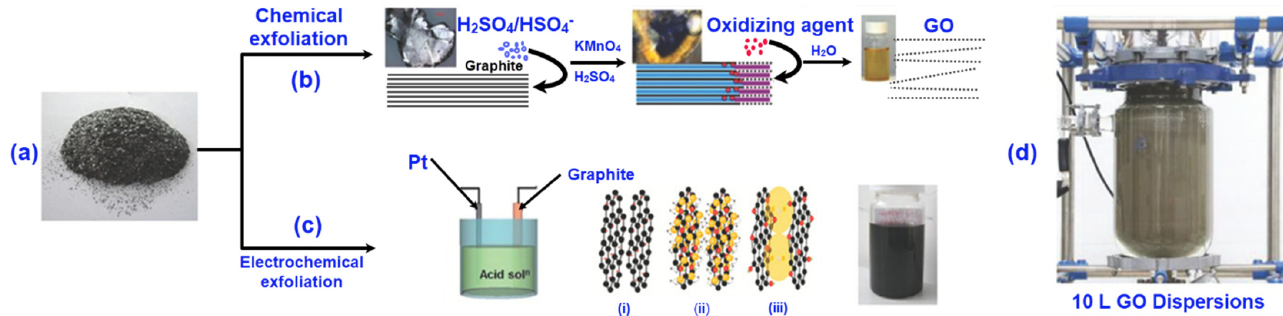
Figure 2. Chemical and electrochemical exfoliation of graphene oxide (GO) from graphite. ( a ) graphite, ( b ) chemical exfoliation approach, ( c ) electrochemical exfoliation approach, and ( d ) GO dispersion in water with a volume of 10 L; Reprinted with permission from [50].